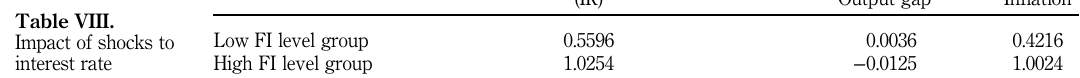
Table VIII. Impact of shocks to interest